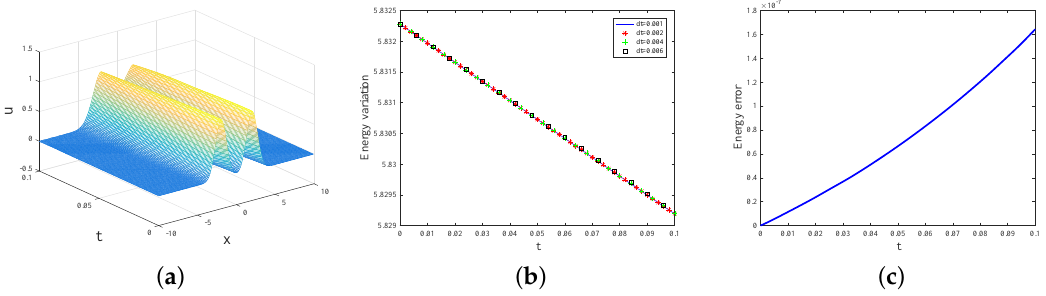
Figure 3. The waveform ( a ), energy variation ( b ) and energy error ( c ) of the scheme (15) at t = 0.1 with M 1 = − 1 and M 2 = − 1.